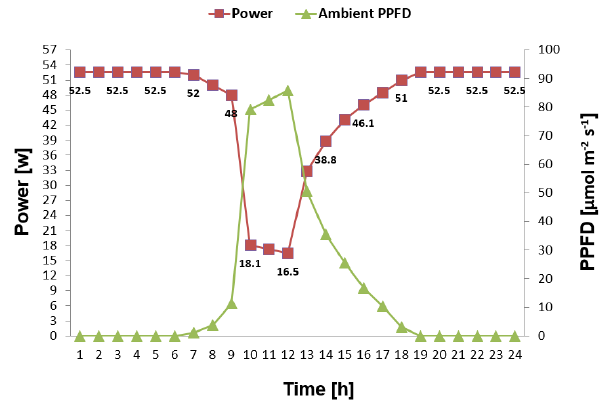
Figure 9. Plant cultivation comparison between conventional and proposed modes over two weeks.